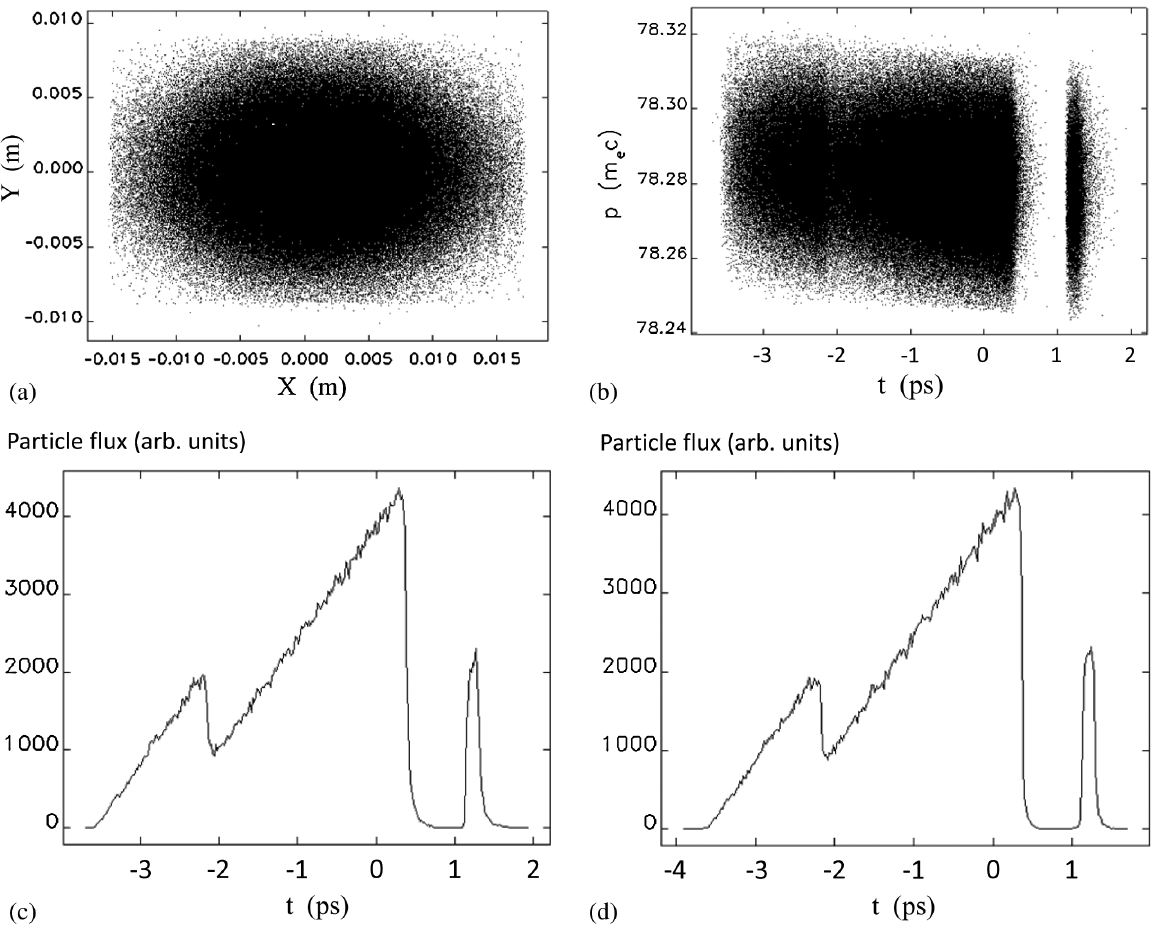
FIG. 6. Elegant third-order simulation of the EEX output beam for the input beam shown in Fig. 2: x - y particles distribution (a); longitudinal momentum and arrival time particles distribution (b); beam temporal profile: without sextupole correctors (c) and with sextupole correctors (d).